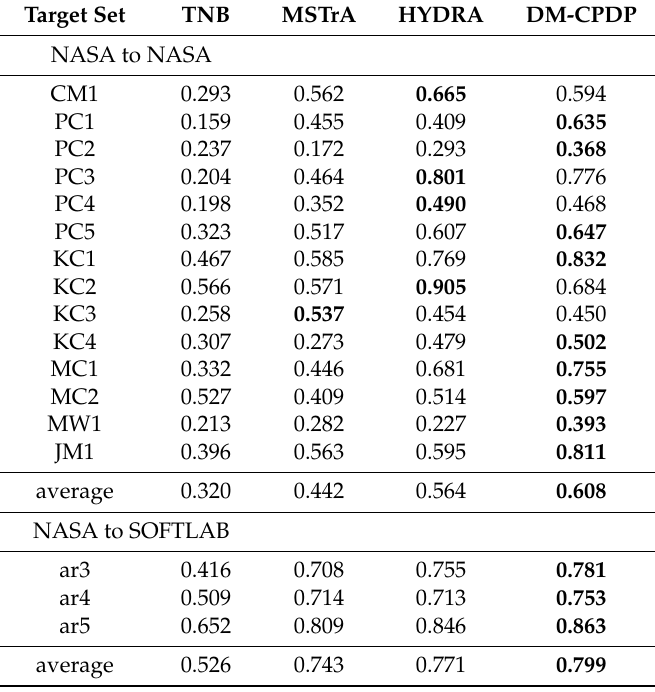
Table 4. Comparison of performance indicators